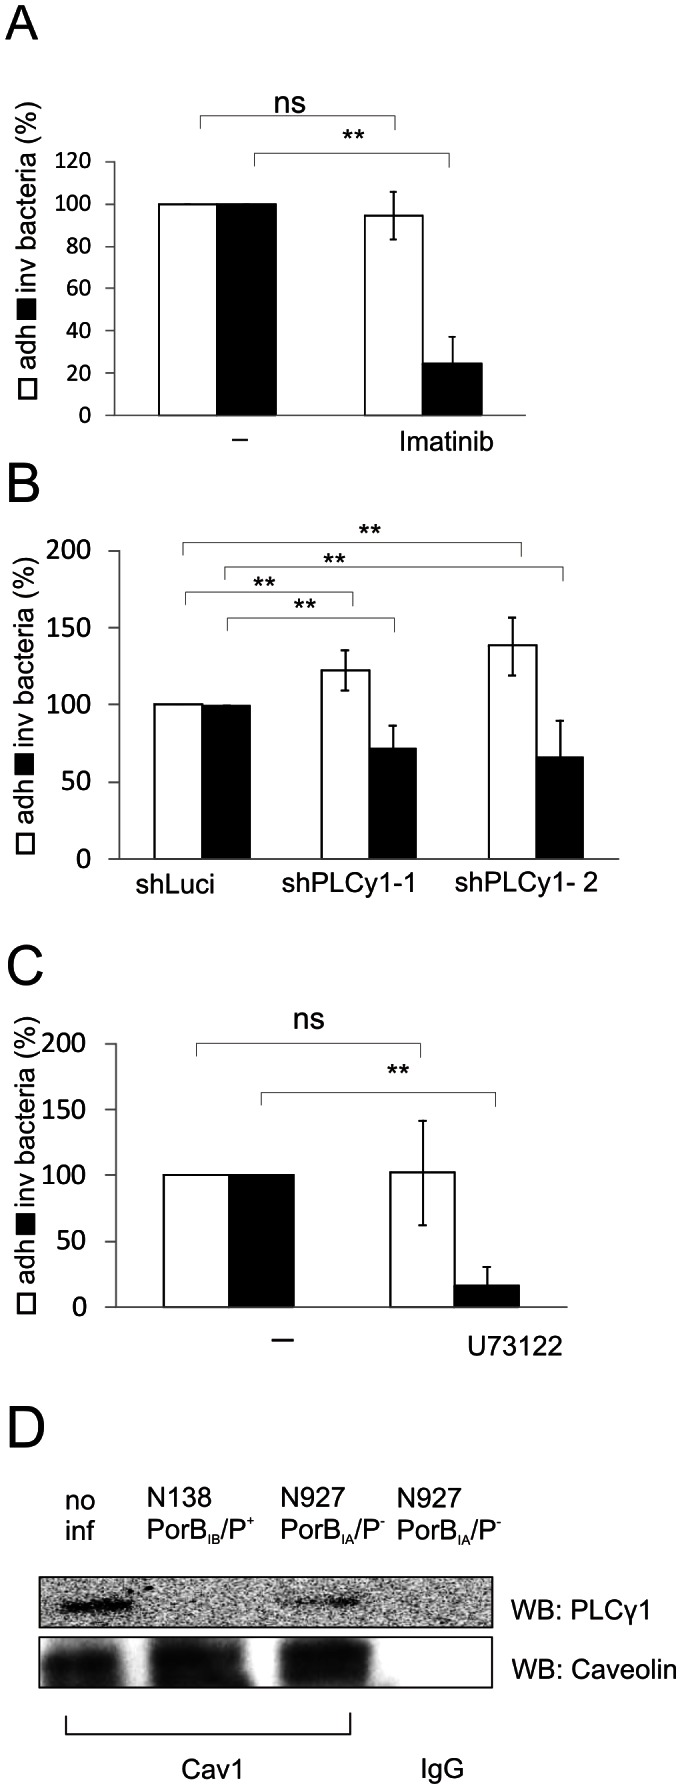
Abl1 and PLCγ1 are essential for N927 invasion.(A) Chang cells were pretreated for 1 h with the Abl1 inhibitor Imatinib (10 µM) and subsequently infected with N927 (PorBIA, P−) at an MOI 10 for 30 min. Adherence (white bars) and invasion (black bars) were quantified by gentamicin protection assays. The number of adherent (adh.) and invasive (inv.) bacteria of untreated control cells was set to 100%. The bar chart shows mean percentages ± SD of three independent experiments each performed in duplicate. (B) shRNA-mediated downregulation of PLCγ1 in Hela cells results in decreased internalization of N927 (PorBIA, P−). Control cells (shLuci) as well as shPLCγ1 cells (shPLCy1-1, shPLCy1-2) were infected with strain N927 (MOI 10, 30 min) and adherence (white bars) as well as invasion (black bars) were analyzed by gentamicin protection assays. The numbers of adherent and invasive bacteria of control cells (shLuci) were set to 100%. Shown are mean percentages ± SD of three independent experiments performed in duplicate. (C) Chang cells were either left untreated (-) or pretreated for 30 min with PLCγ1 inhibitor U73122 (10 µM) and infected with N927 (MOI 10, 30 min). Adherence (white bars) and invasion (black bars) were quantified by gentamicin protection assays. The numbers of adherent (adh.) and invasive (inv.) bacteria of untreated control cells were set to 100%. The graph shows mean values ± SD of three independent experiments performed in duplicates. (D) PLCγ1 co-precipitates with Cav1 in N927-infected cells and untreated cells. Chang cells were infected with either N927 (PorBIA,P−) or N138 (PorBIB,P+) MOI 20 for 1 h. Endogenous Cav1 was precipitated from infected and not infected control (no inf) cells and co-precipitated PLCγ1 was detected by Western blot. p<0.01: **.